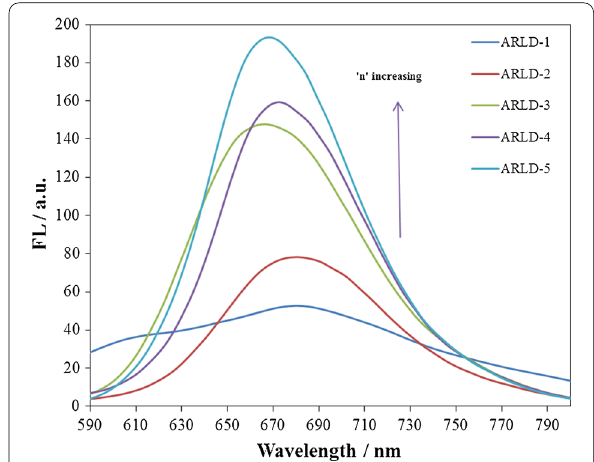
Fig. 5 The changes in the fluorescence intensity of